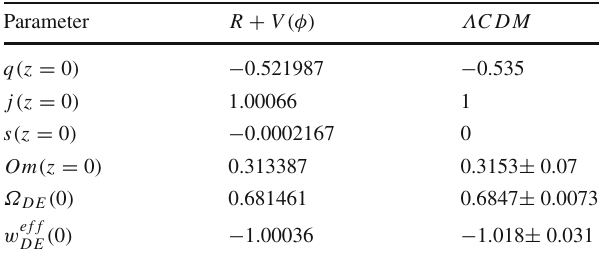
Table 1 Cosmological parameter values at the present epoch for Q > 0, with α = 0 . 9 and η = 0 . 0004